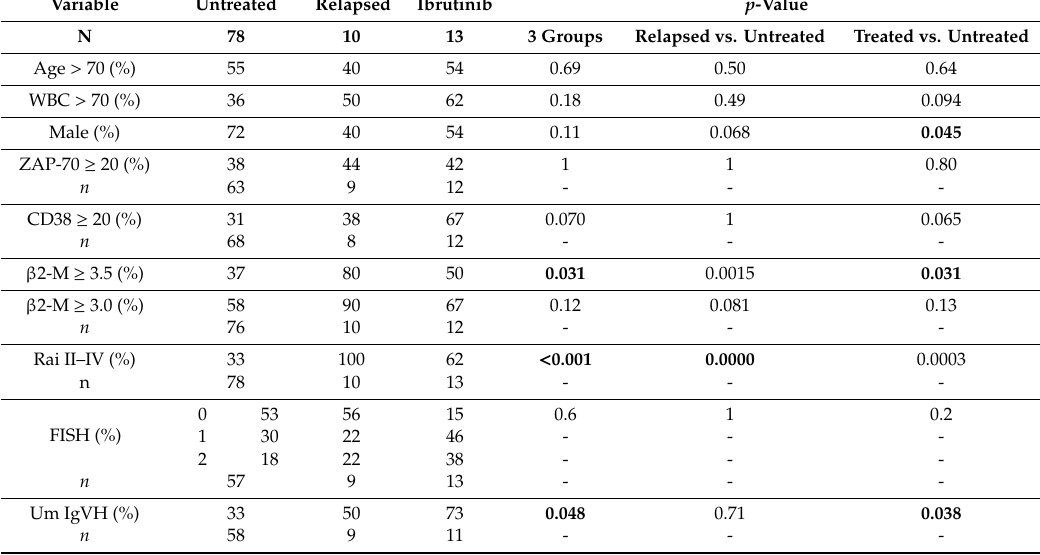
Table 3. Comparison of untreated, relapsed, and ibrutinib-treated CLL patients. Comparison of prognostic markers in untreated (U), relapsed (R), and ibrutinib-treated (I) CLL samples. WBC, white blood cell count; ZAP-70, zeta-chain-associated protein of 70 kD; CD38, cluster of di ff erentiation 38; FISH, fluorescence in situ hybridization; IgVH, immunoglobulin variable heavy chain; Um,